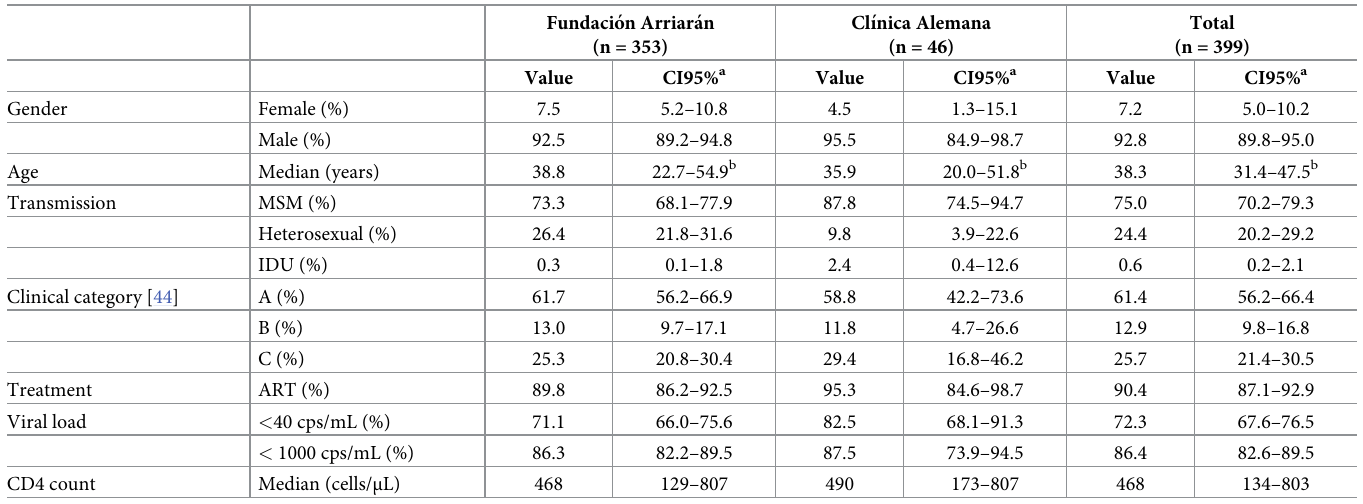
Table 2. Comparison of demographic, clinical, and laboratory characteristics of the participants from the two HIV centers in Santiago, Chile.